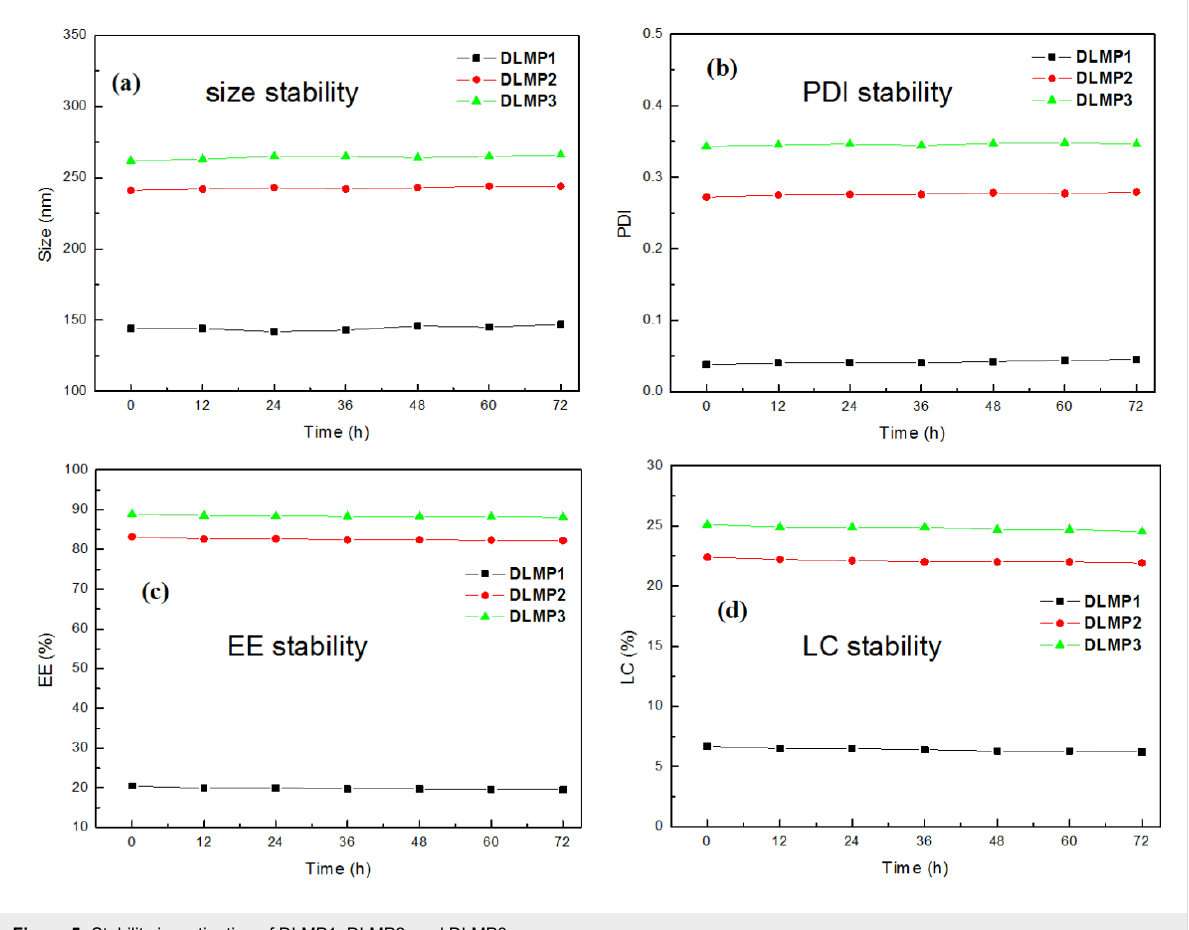
Figure 5: Stability investigation of DLMP1, DLMP2, and DLMP3.